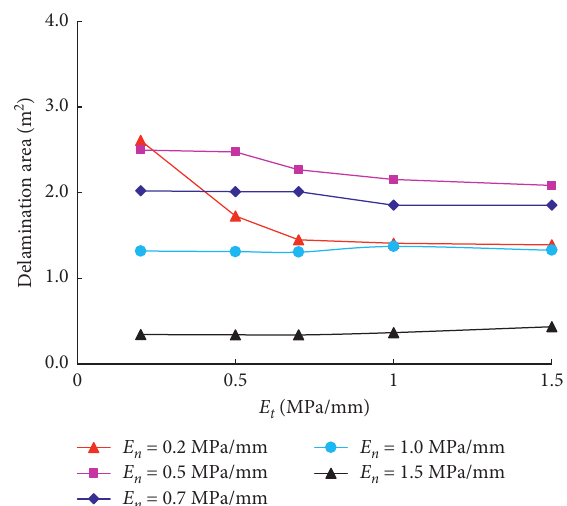
t for various impact